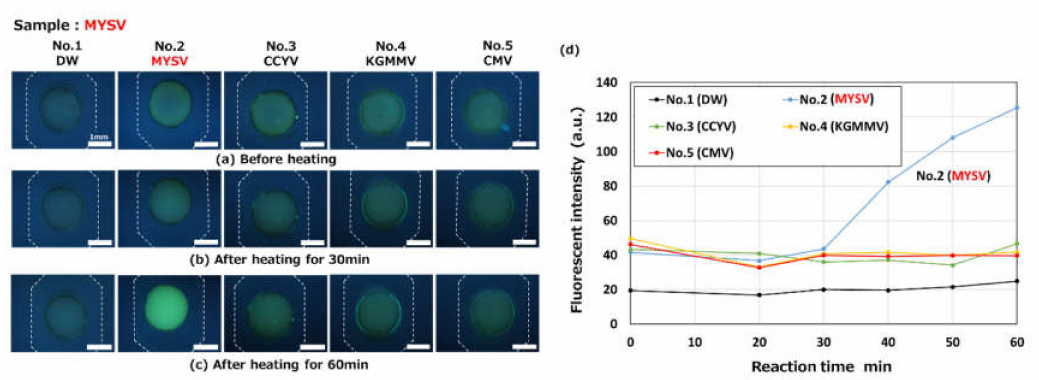
Figure 15. Fluorescence microscopy images showing the reverse transcription LAMP (RT-LAMP) detection of an RNA-based plant virus (melon yellow spot virus, MYSV) observed ( a ) before heating and after heating for ( b ) 30 min and ( c ) 60 min at 63 ◦ C (taken with an optical filter BV-2A, gain: 1 × , exposure time: 2 s). A primer set for the detection of MYSV was pre-spotted in a reaction chamber (No. 2). ( d ) Changes in fluorescence intensities as a function of the reaction time. The concentration of total RNA, containing the MYSV viral RNA target, was 22.2 ng / µ L after mixing with the LAMP reagents.